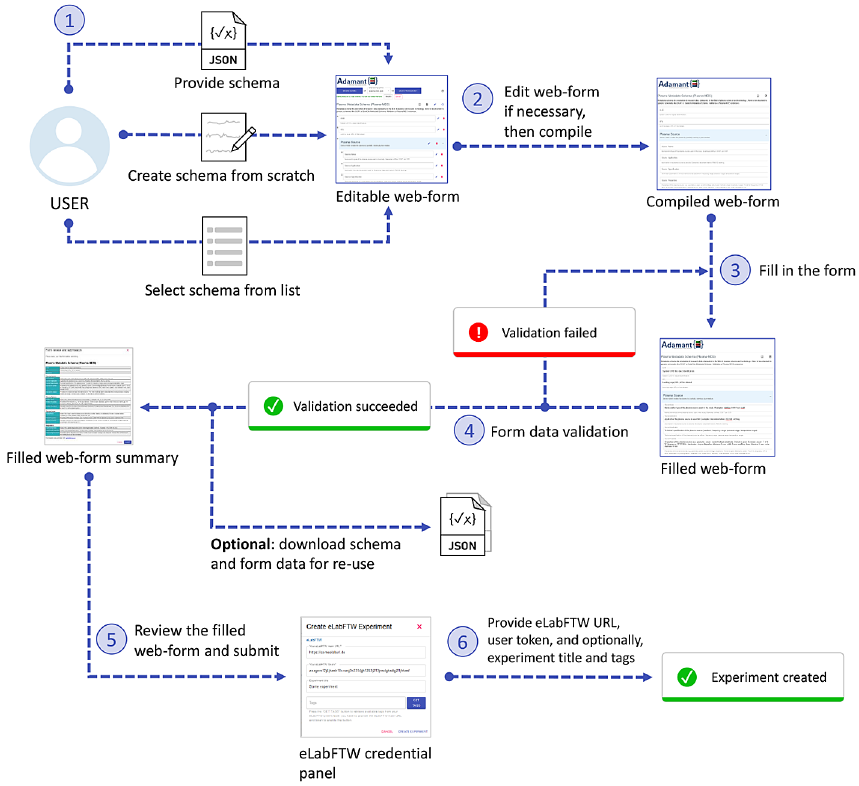
Figure 4. Workflow for creating a new experiment in the eLabFTW system with